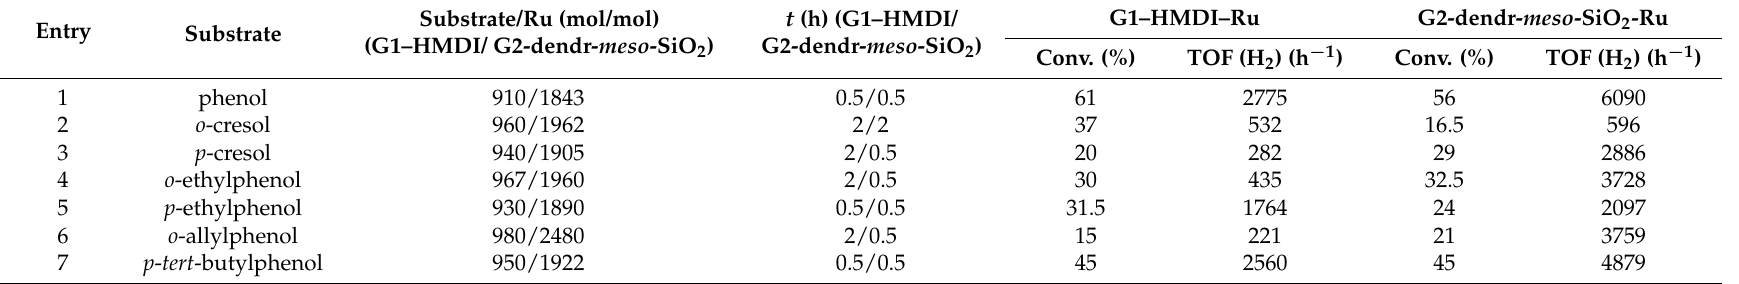
Table 4. Activities comparison for G1–HMDI–Ru [57] and G2-dendr- meso -SiO 2 -Ru in the hydrogenation of alkyl-substituted phenols 1